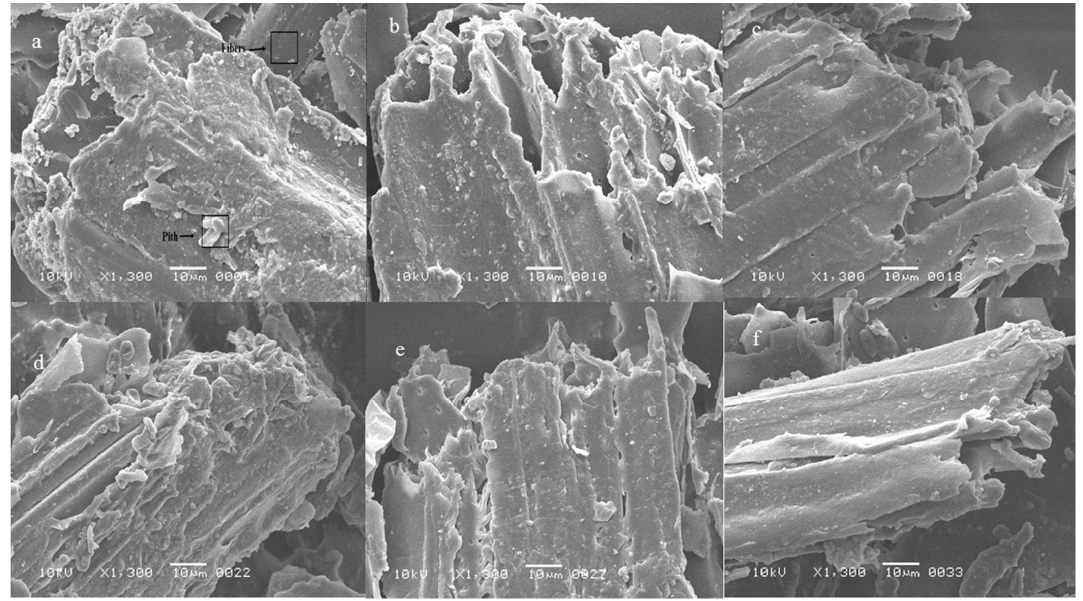
Figure 2. Scanning electron microscopy of ( a ) untreated SB, ( b ) untreated SB obtained after experiment 1, ( c ) after experiment 2, ( d ) after experiment 3, ( e ) after experiment 4, ( f ) after experiment 5.